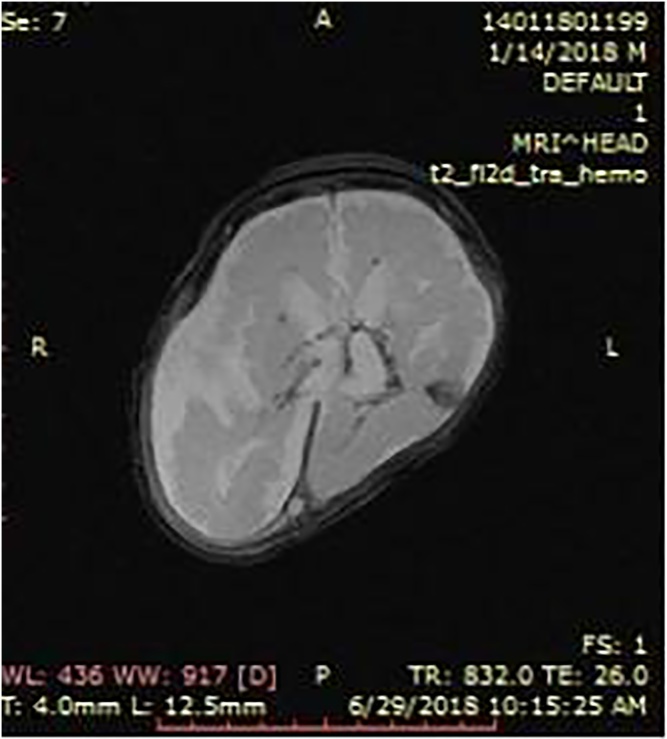
MRI scan, axial view, depicting the remaining hemosiderin deposits within the ventricular system.